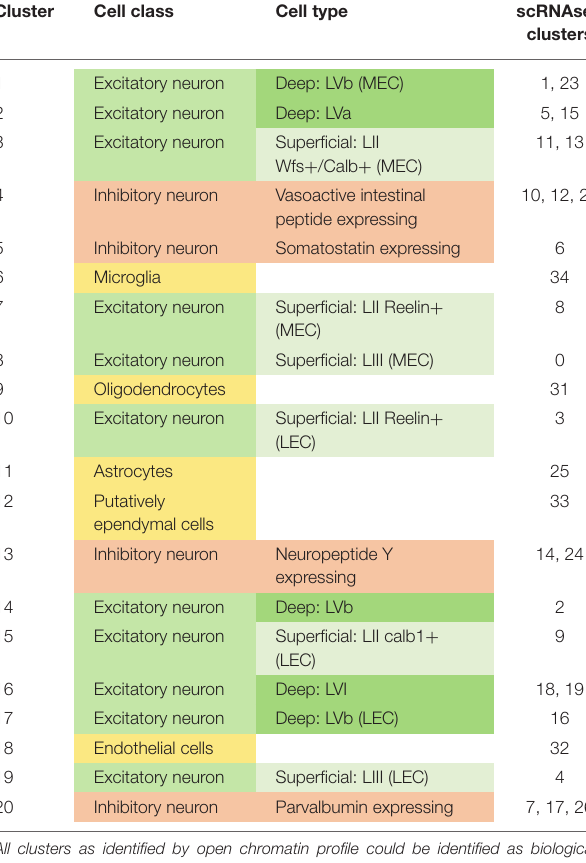
TABLE 1 | Overview of cell types in scATAC-seq clusters. Cluster